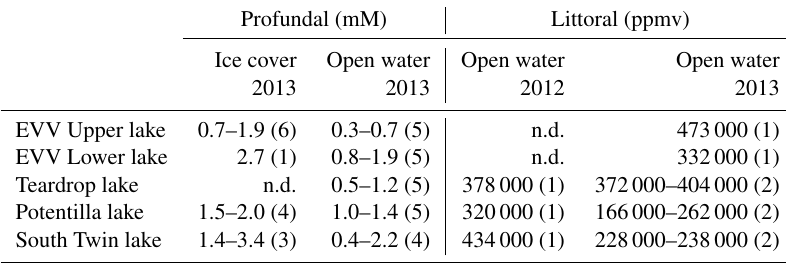
Table 4. Ranges of CH 4 concentrations in profundal sediments and littoral sediment gas bubbles.